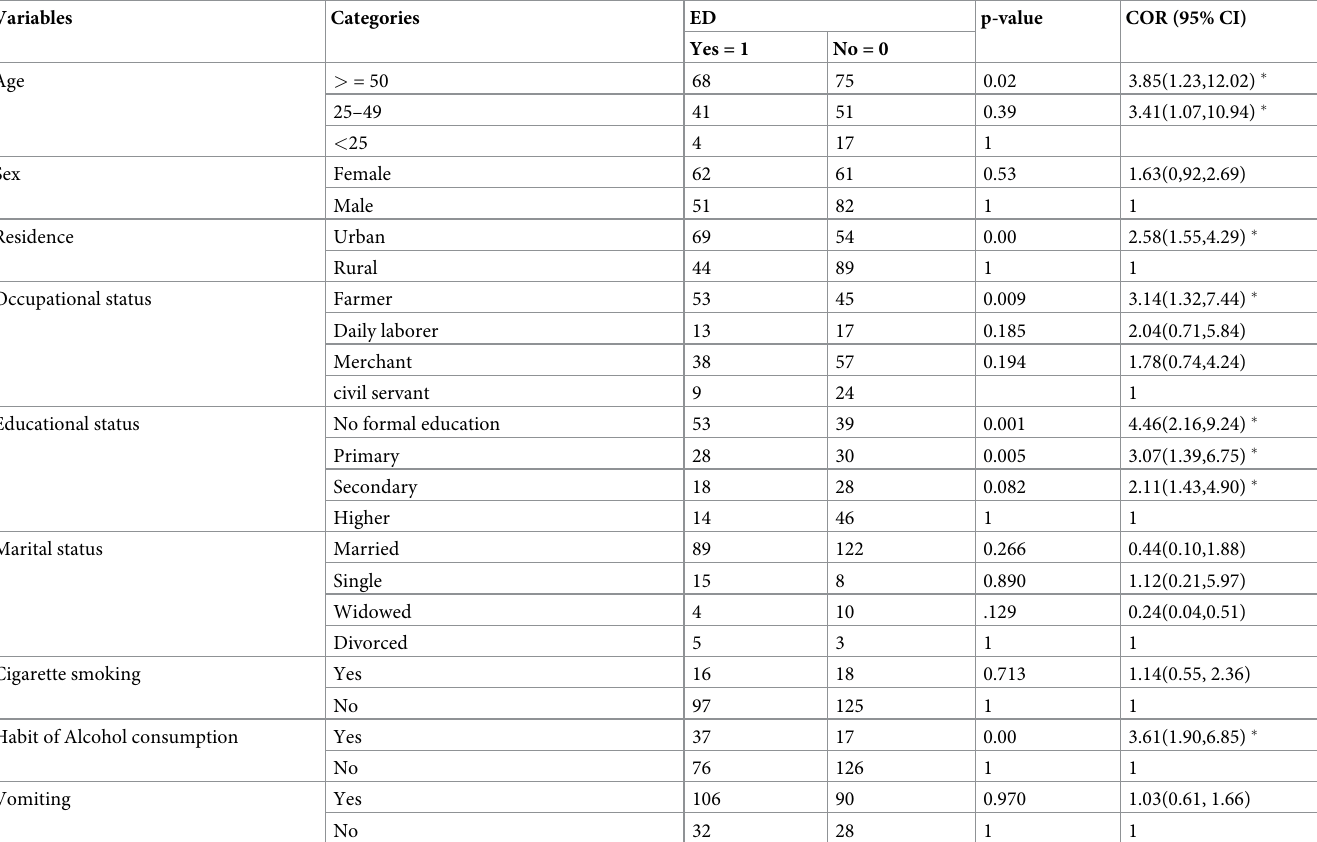
Table 3. Bivariate analysis of factors associated with electrolyte disturbances among patients admitted to medical ward with metabolic syndromes, in Jimma Medi- cal Center, South west Ethiopia from April-May 2019.